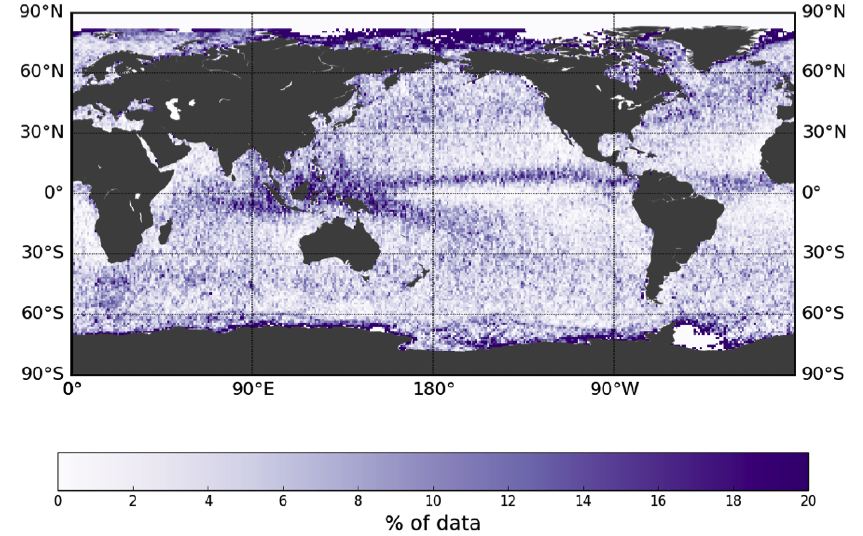
Figure 21. Percentage of 1 Hz flagged samples using the operational MP algorithm for which the ILWC >0.1 kg/m 2 for 1 year (cycles 100 to